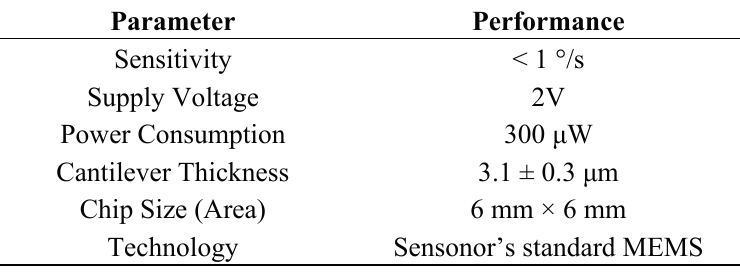
Table 1. Summary of the Specifications of the proposed angular-rate